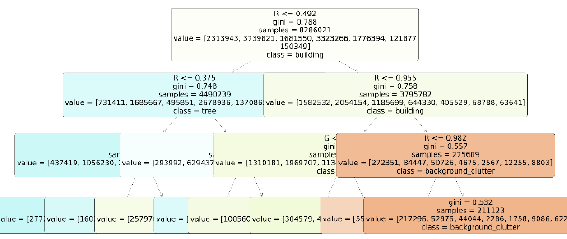
Figure 4 . The structure of one of the decision trees from our random forest algorithm (tenth decision tree).